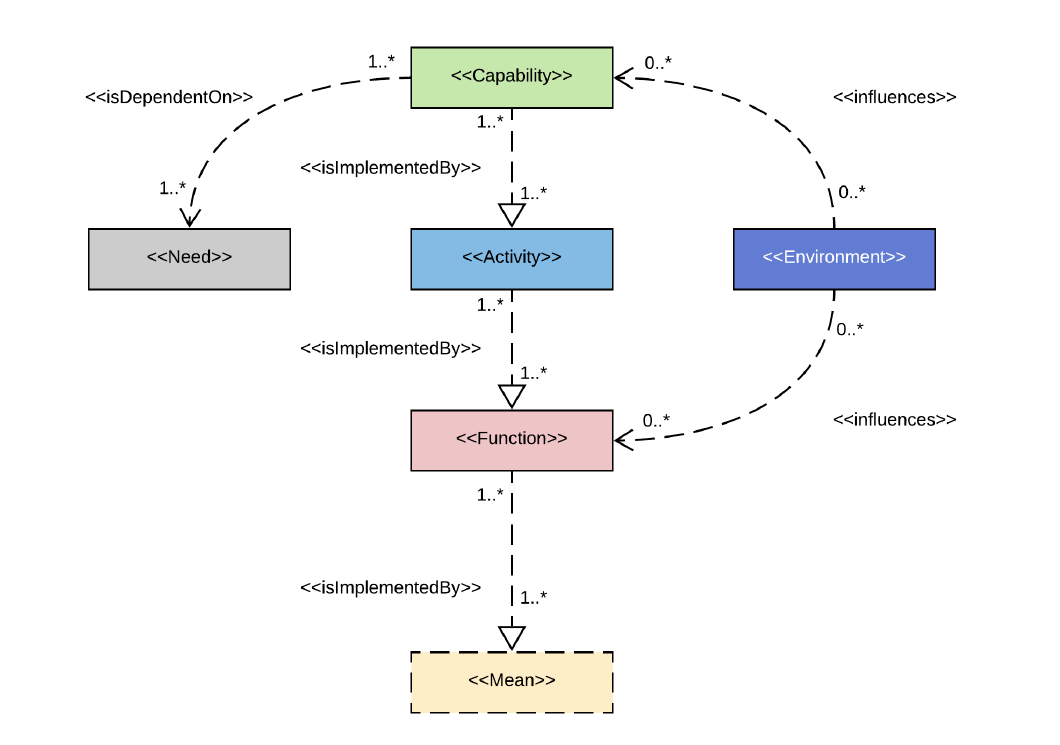
Figure 5. A Unified Modelling Language (UML) diagram of the breakdown approach, with the rela- tionships between needs, capabilities, activities, functions, means and the